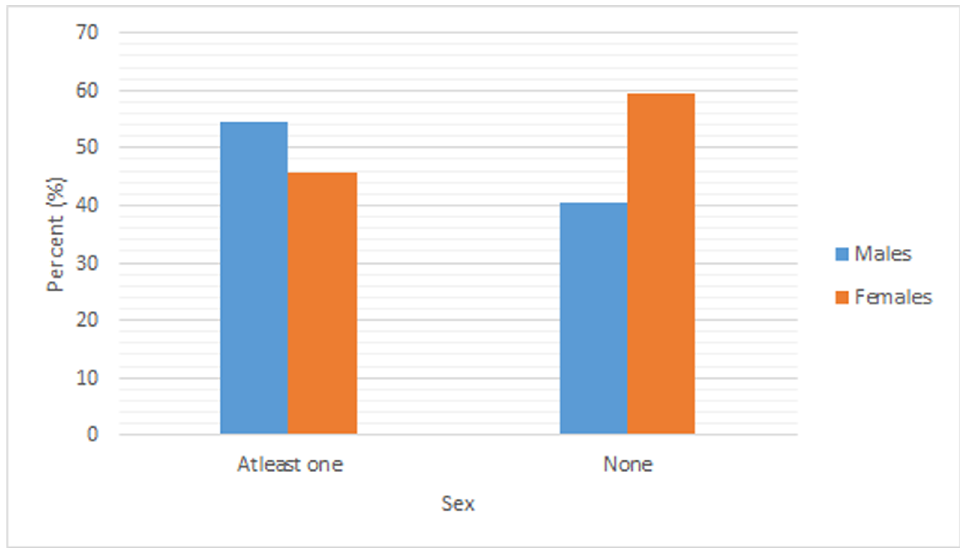
Fig 1. Weighted percentage distribution of social activity participation (at least one or none) by sex among youth in South Africa, 2008.